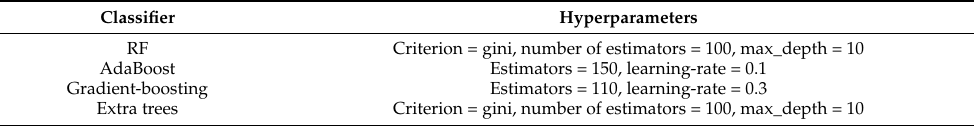
Table 3. Optimal hyperparameters using grid search optimization.